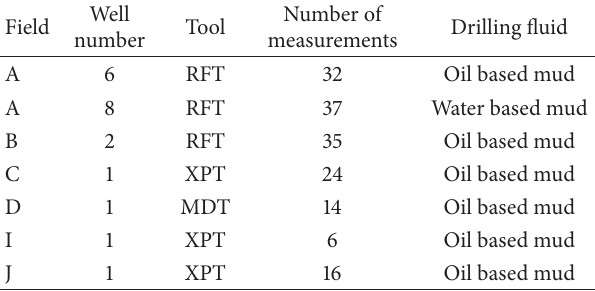
Table 1: The list of used in situ pressure data points for each